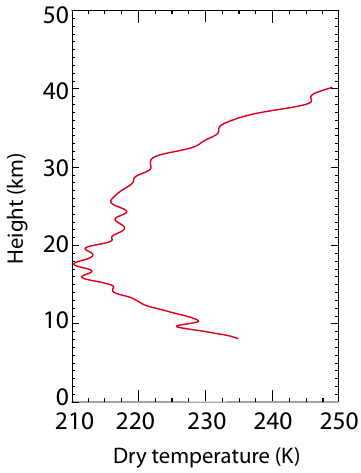
Figure 2. The dry temperature profile corresponding to the occultation event 2011-03-11 04:08:29 UTC.